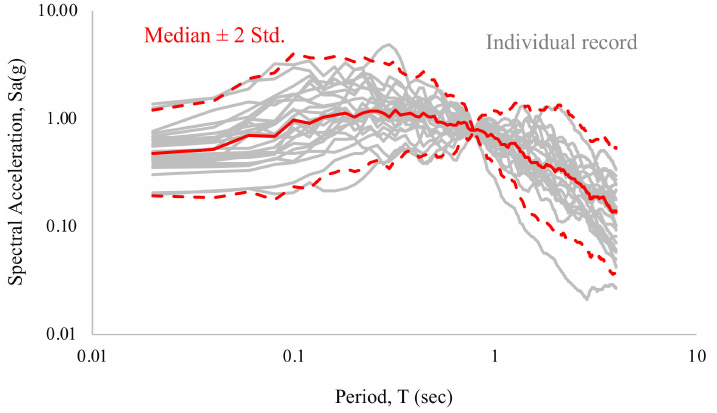
Figure 18. Acceleration response spectrum of the selected twenty-four ground motions linearly scaled and conditioned on the building period T 1 = 0.78 s.